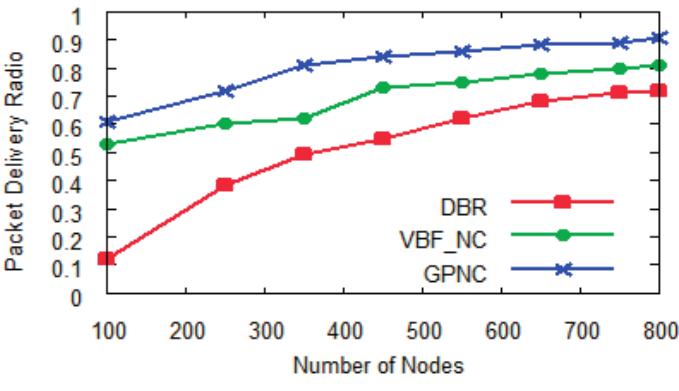
Figure 11. Packet delivery ratio with the number of nodes when N =